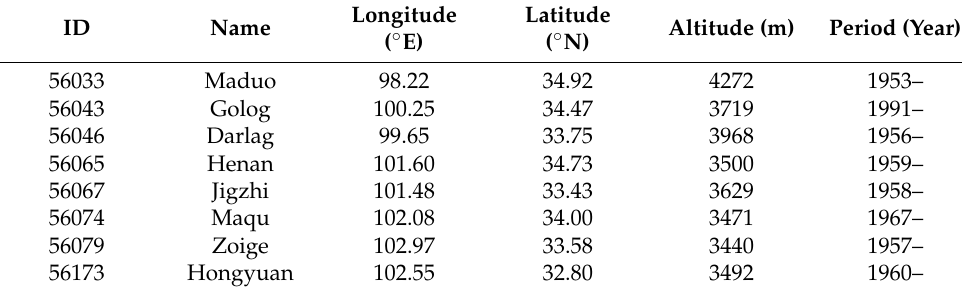
Table 1. Meteorological stations in the source region of the Yellow River.